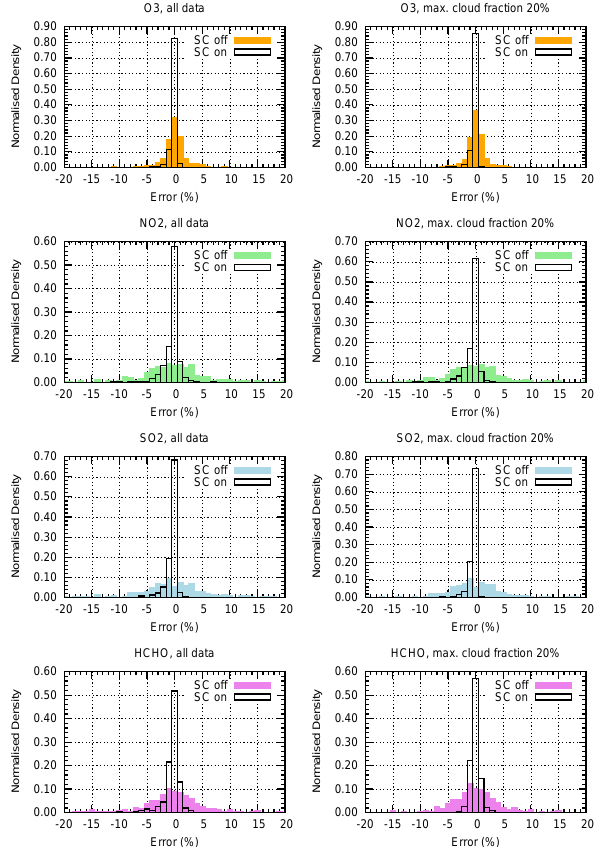
Fig. 8. Histograms of systematic errors due to scene inhomogene- ity. The y-axis shows the number of sub-pixels with error in each bin (binsize 1%), normalised to the total number of sub-pixels. Coloured boxes: without spectral calibration (SC); open boxes: with spectral calibration; left panels: based on all data; right panels: based on only data with maximum cloud fraction of 20%.